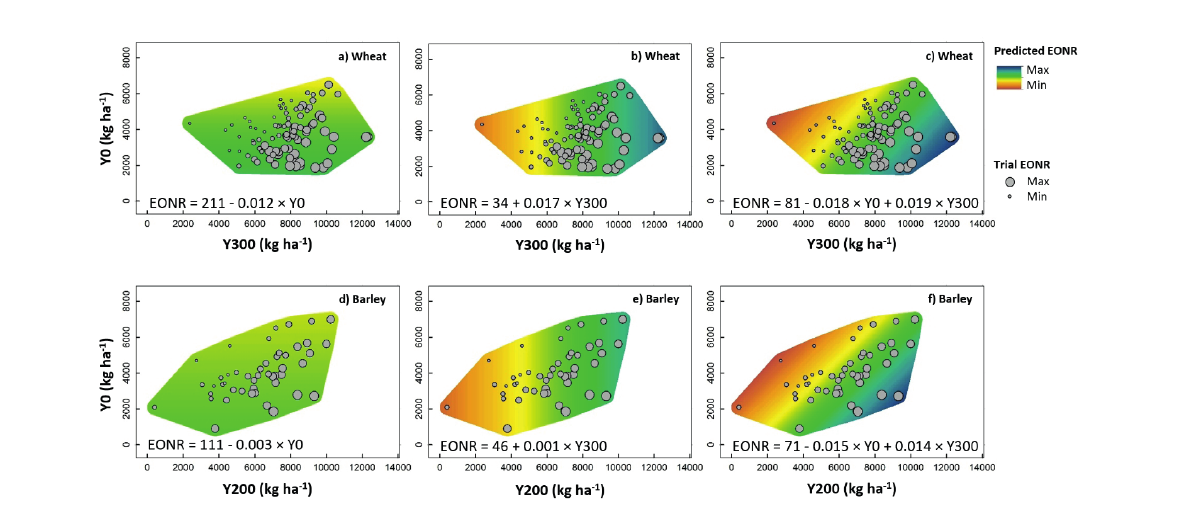
Fig. 4. Univariate and bivariate linear regression models for prediction of economic optimal nitrogen rate (EONR). The models were parameterised by all trial data (no trials left out). The filled circles show the EONR of the individual trials and the colour scale shows the prediction surface. The circle size and the colour scale of the surface are the same within each row of plots but different between the rows (i.e. comparable between predictor sets of the same crop, but not comparable between crops). Y0 = yield at 0 kg N ha -1 , Y200 = yield at 200 kg N ha -1 and Y300 = yield at 300 kg N ha